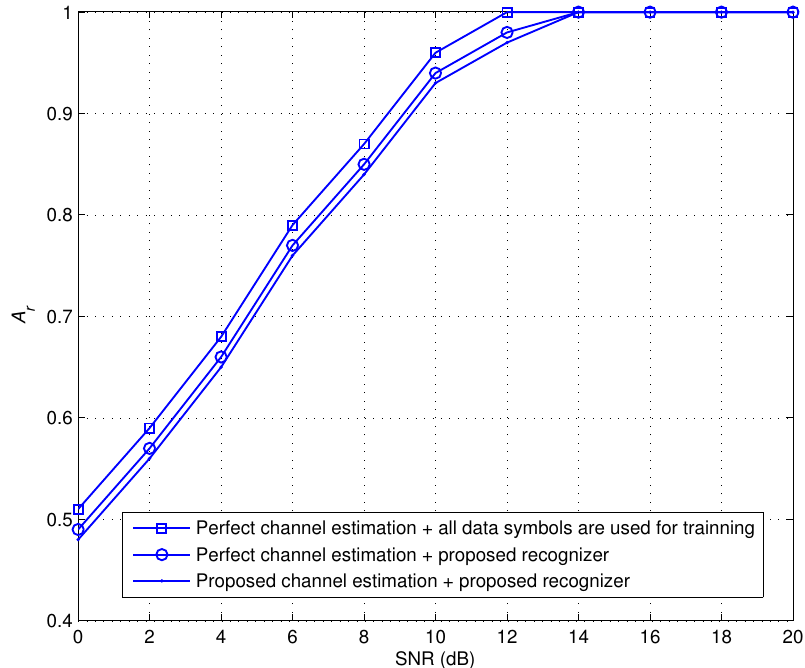
Figure 3. A r performance at different scenarios.